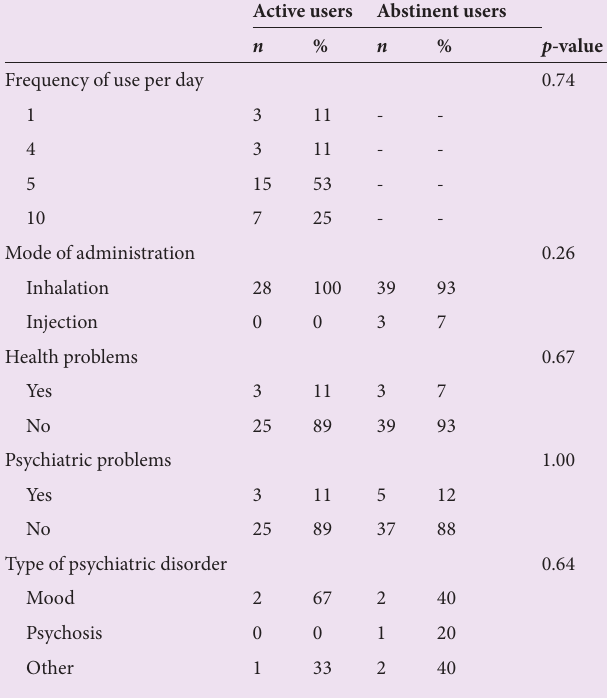
Table 3. Clinical data of active heroin users v. abstinent users during the 4 years after admission for heroin detoxification at the Opioid Detoxification Unit at Stikland Hospital